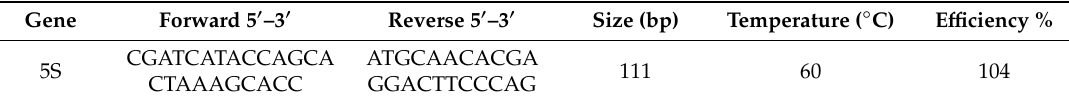
Table 4. 5S rDNA homologous sequence clone